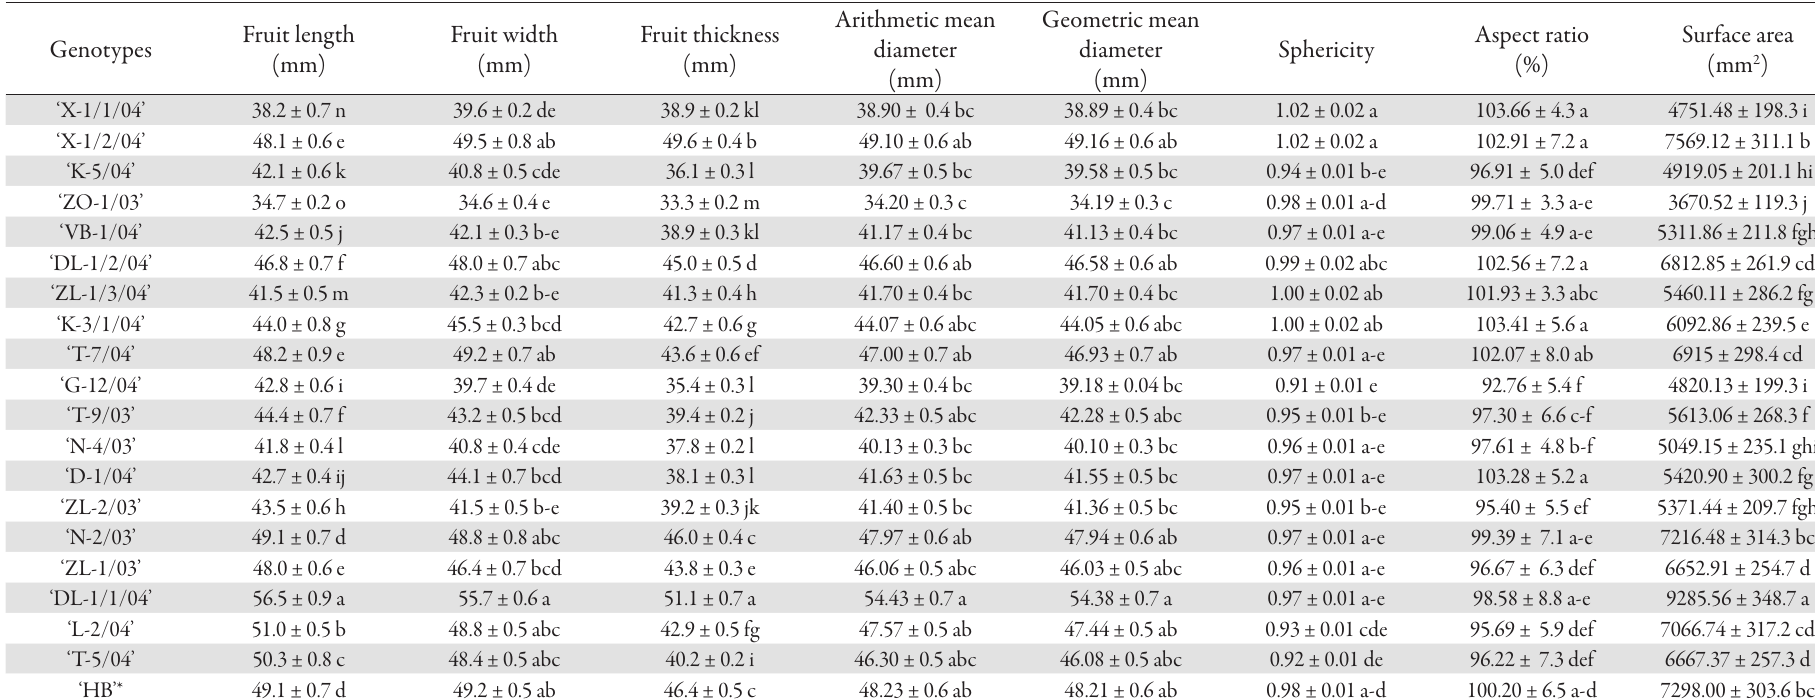
Tab. 2. Fruit linear dimensions, arithmetic mean diameter, geometric mean diameter, sphericity, aspect ratio and surface area of apricot